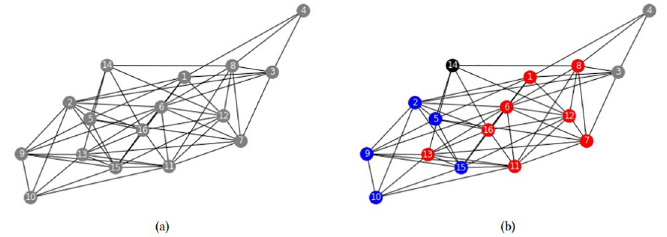
Fig 7. Highland tribes community structures. Community structures obtained by (a) F ∗ with parameters n p = 1, (b) F ∗ Sh (cid:0) Mod